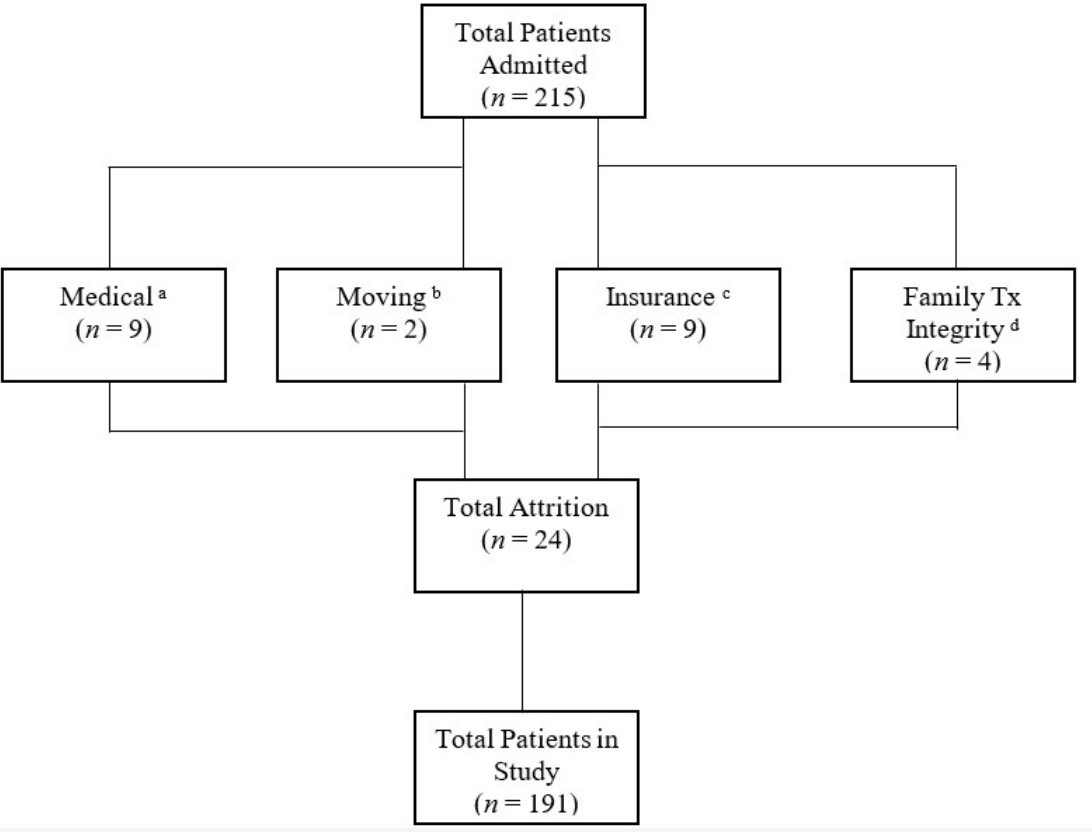
Figure 1. a Patients failed swallow study or other medical concerns arose. b Family moved outside of geographical area. c Continuity of care to new insurance carrier denied. d Family unable to follow the treatment plan in the absence of the case manager. Tx= treatment.